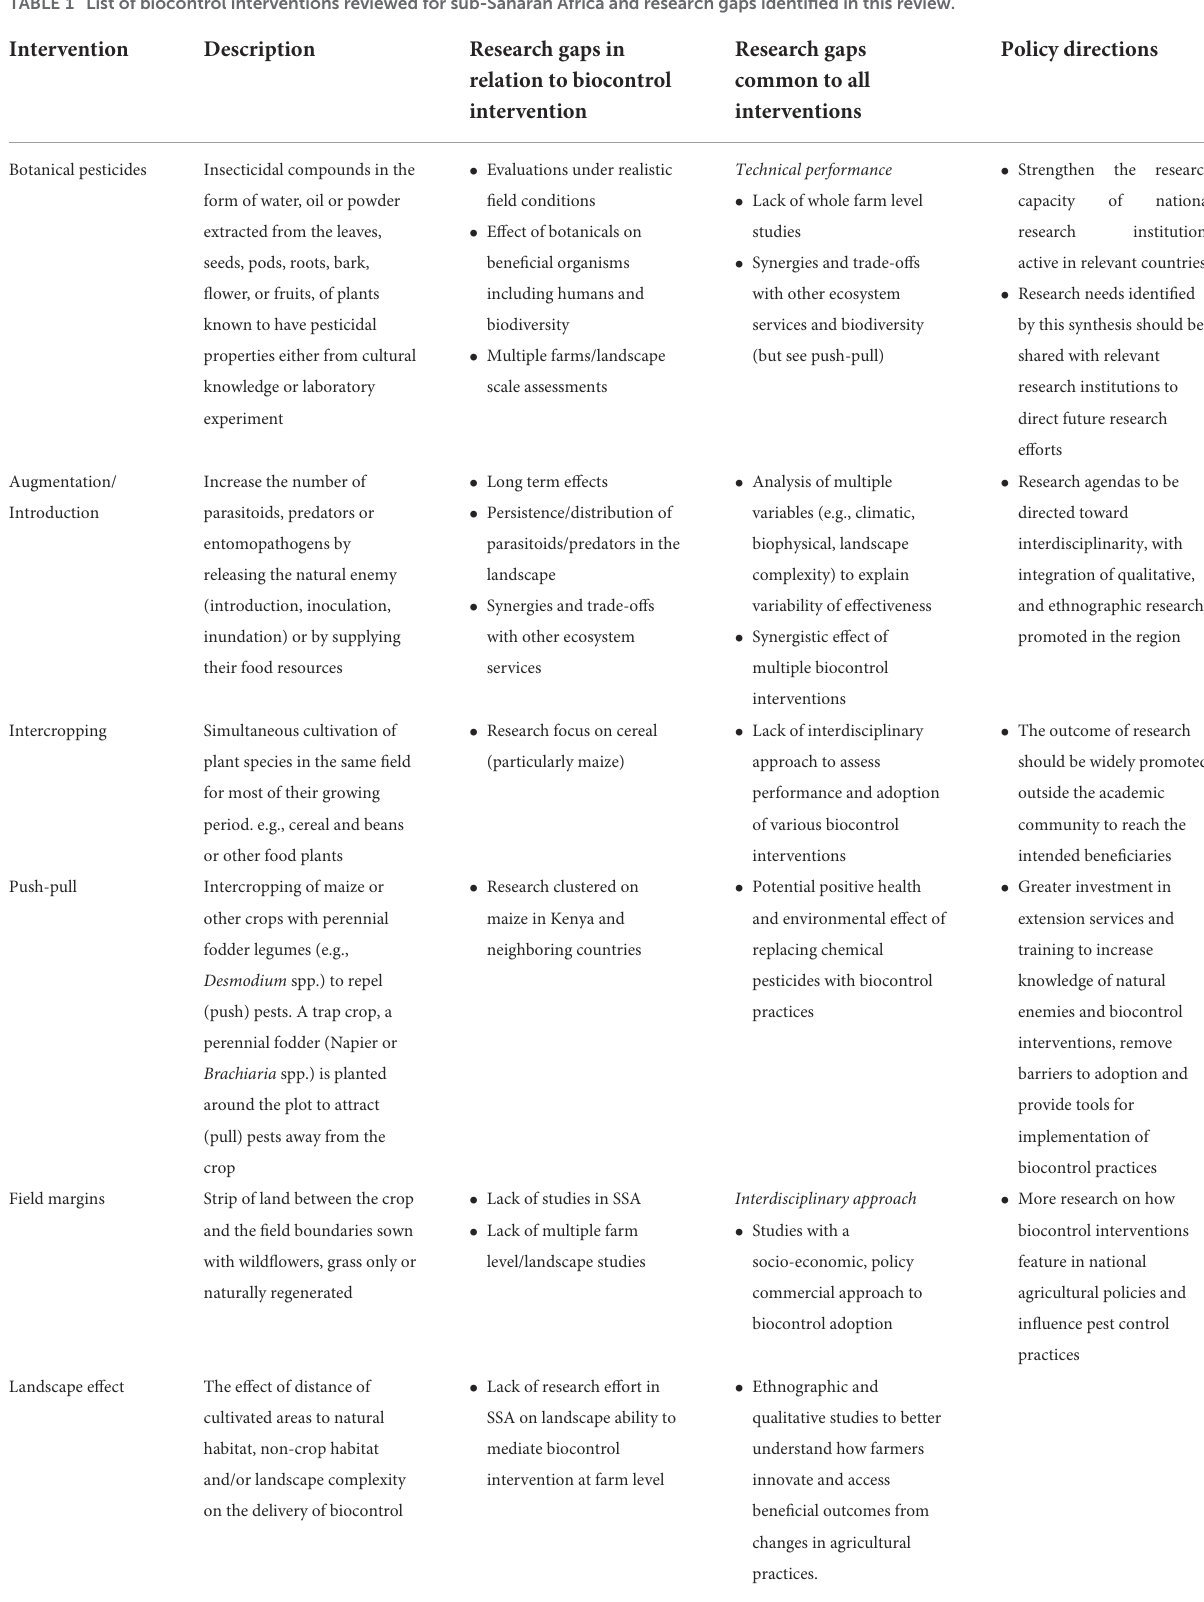
TABLE 1 List of biocontrol interventions reviewed for sub-Saharan Africa and research gaps identified in this review.